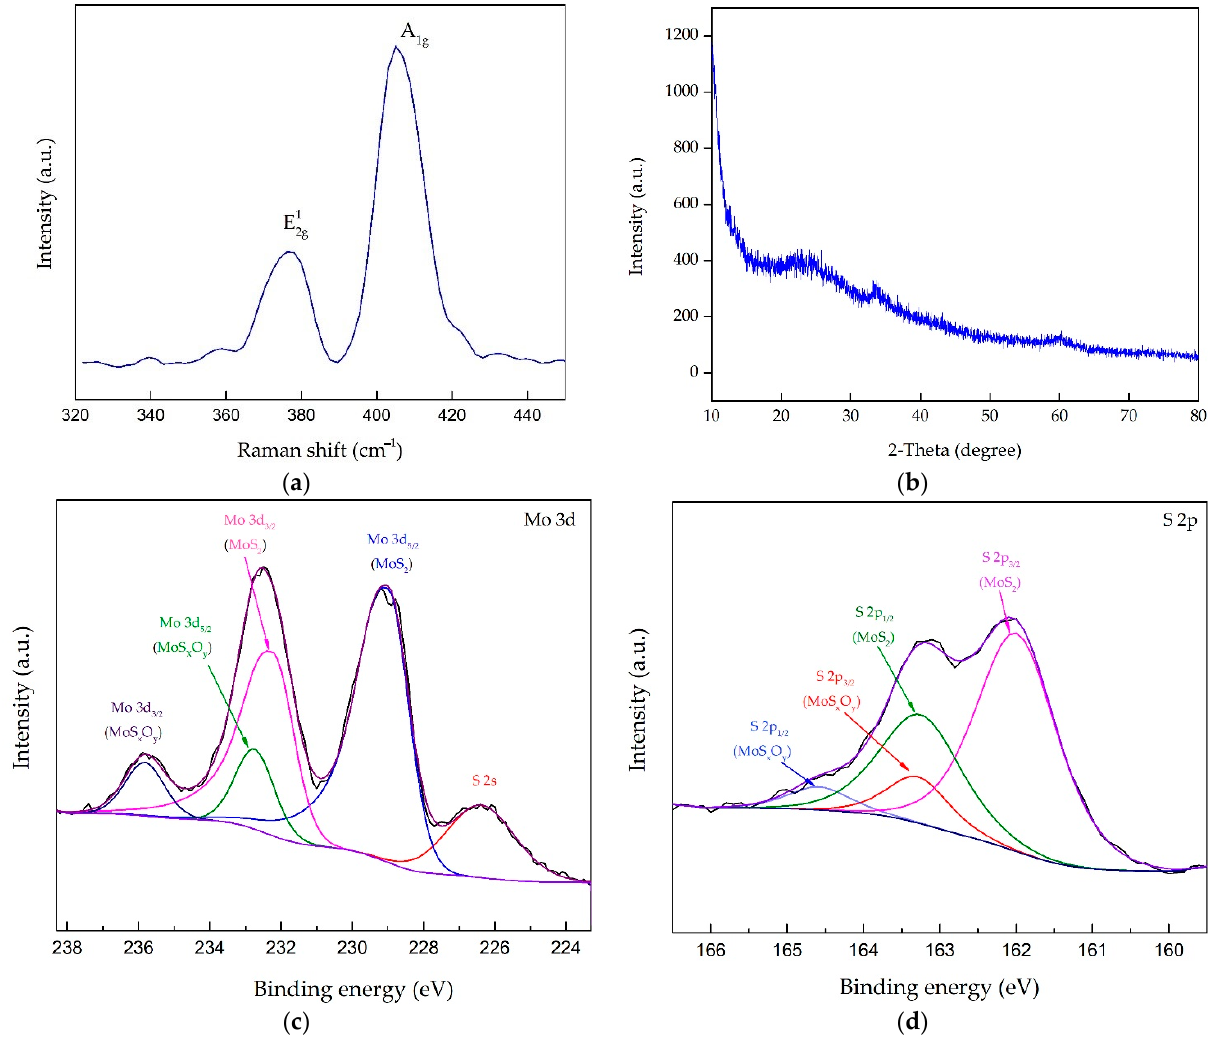
Figure 9. ( a ) Raman spectrum of MoS 2 ; ( b ) X-ray powder diffraction (XRD) pattern of MoS 2 grown on PDMS substrates; ( c , d ) Mo3d and S2p X-ray photoelectron spectroscopy (XPS) spectra of MoS 2 .